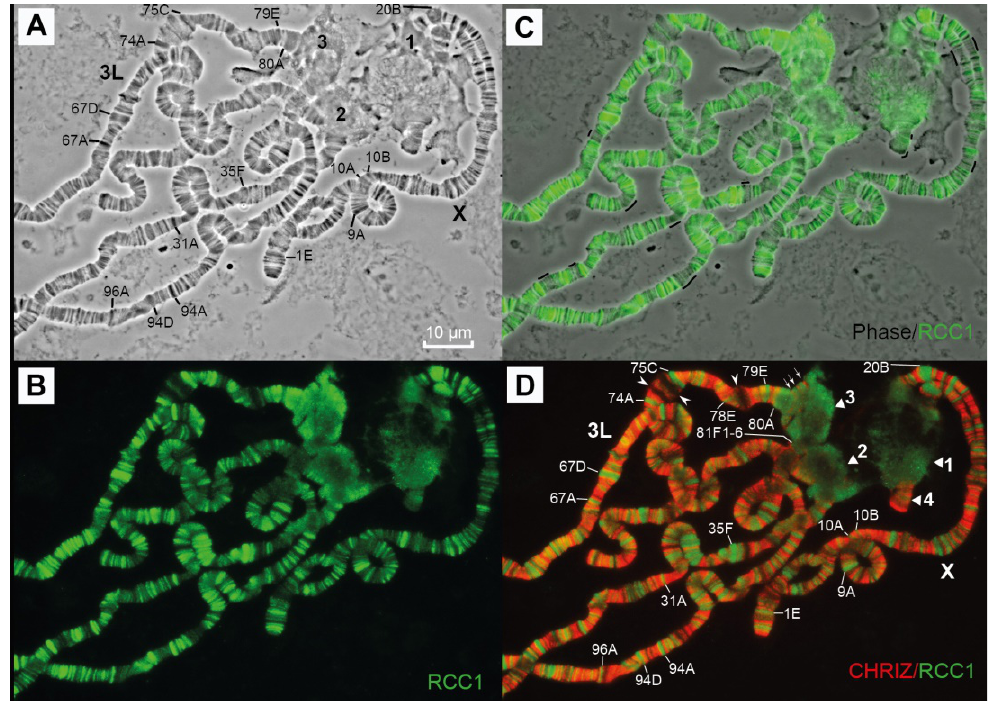
Figure 14. Immunolocalization of the RCC1 protein in polytene chromosomes of D. melanogaster . ( A ) Phase contrast; ( B ) localization of antibodies to the RCC1 protein; ( C ) localization of antibodies to the RCC1 protein and phase contrast; black lines near chromosomes correspond to the long sequences of unlabeled grey bands; ( D ) localization of antibodies to the RCC1 and CHRIZ pro- teins. Genotypes in all figures are Rif1 1 . The numbers 1, 2, 3 and 4 in ( D ) designate heterochro- matic regions in the X, second, third and fourth chromosomes, respectively. Scale bar value is the same for every figure.